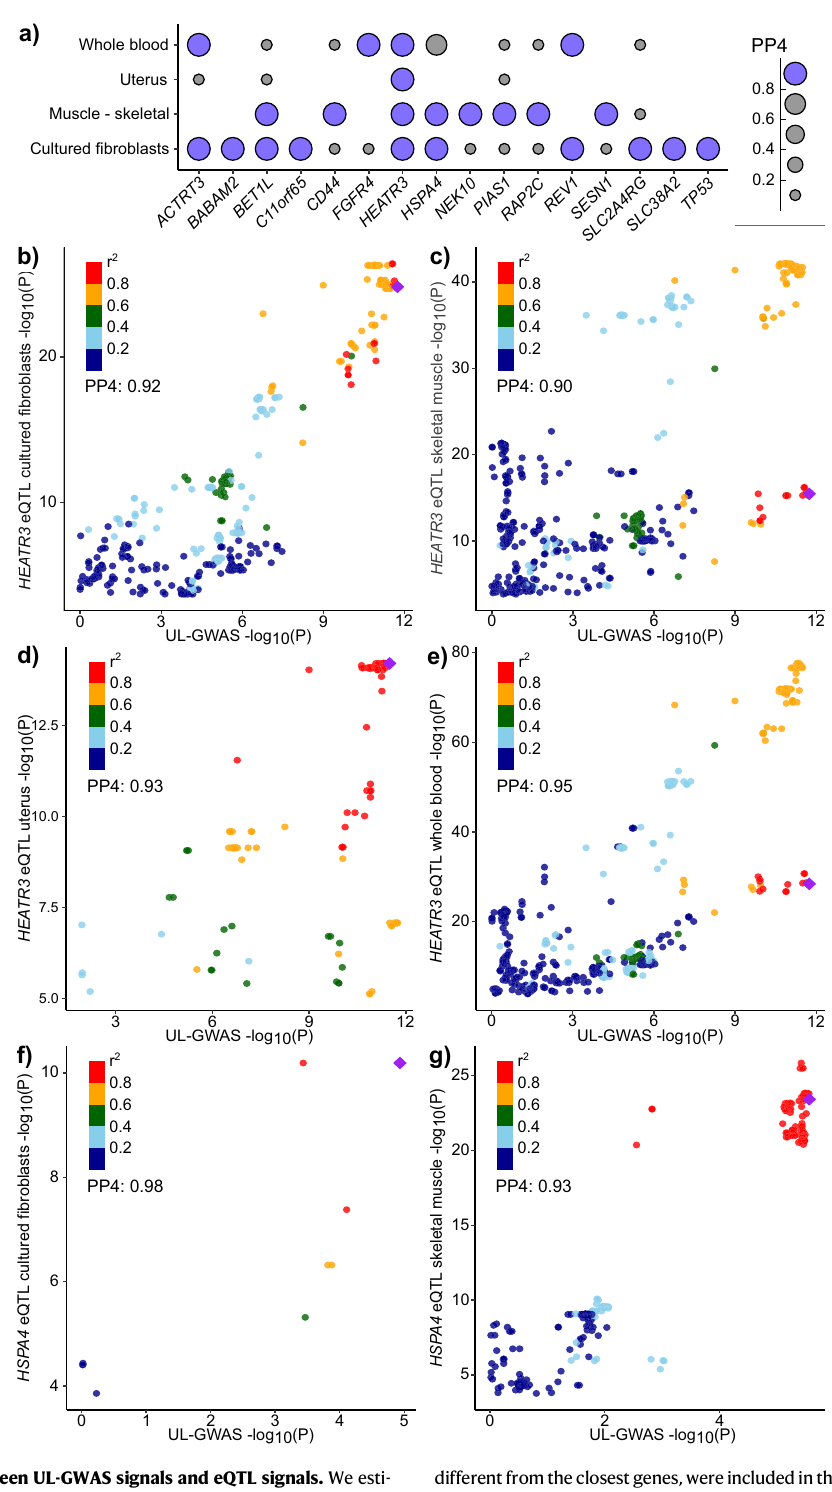
differentfromtheclosestgenes,wereincludedintheanalysis(TableS2).The fi gure illustrates a allgenes, the expression ofwhichcolocalizeswith UL signal(posterior probability for a single causal variant [PP4] >0.8) in at least one of the studied tissues, as well as colocalization signals for HEATR3 in b cultured fi broblasts, c skeletal muscle, d uterus, and e whole blood, and for HSPA4 in f cultured fi bro- blasts, and g skeletal muscle. Genetic correlations with metabolic and anthropometric traits We used LDSC software 21 to evaluate the genetic correlations ( r g ) of UL with 20 metabolic and anthropometric traits (Fig. 5a, Table S11,